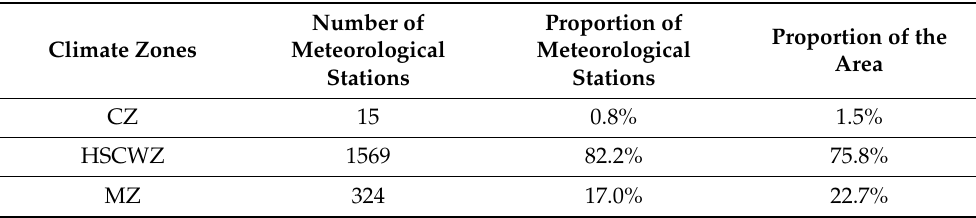
Table 3. Proportions of the meteorological stations and area in climate zoning for refined building thermal design climate zoning in Chongqing based on China’s GB50176-2016. Number of Climate Zones